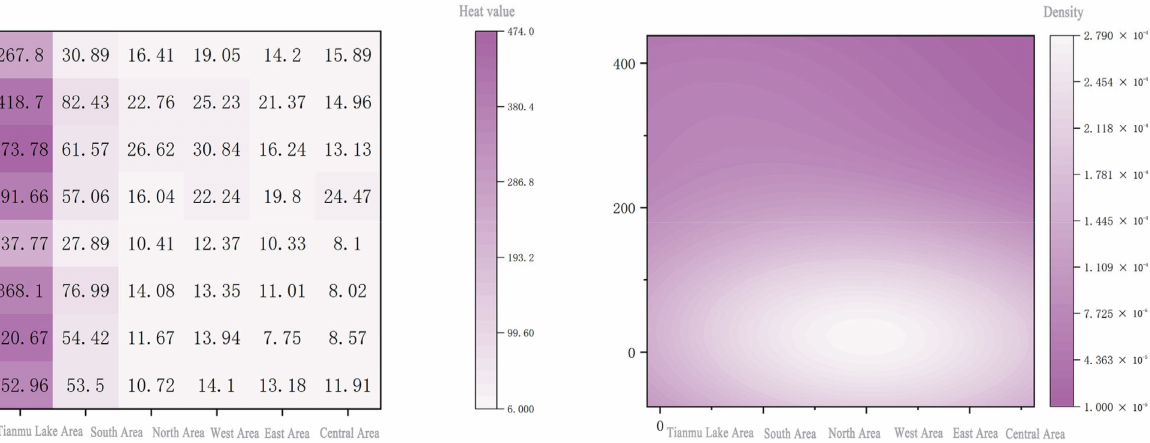
Figure 4. Dynamic thermal measurements in tourist areas.